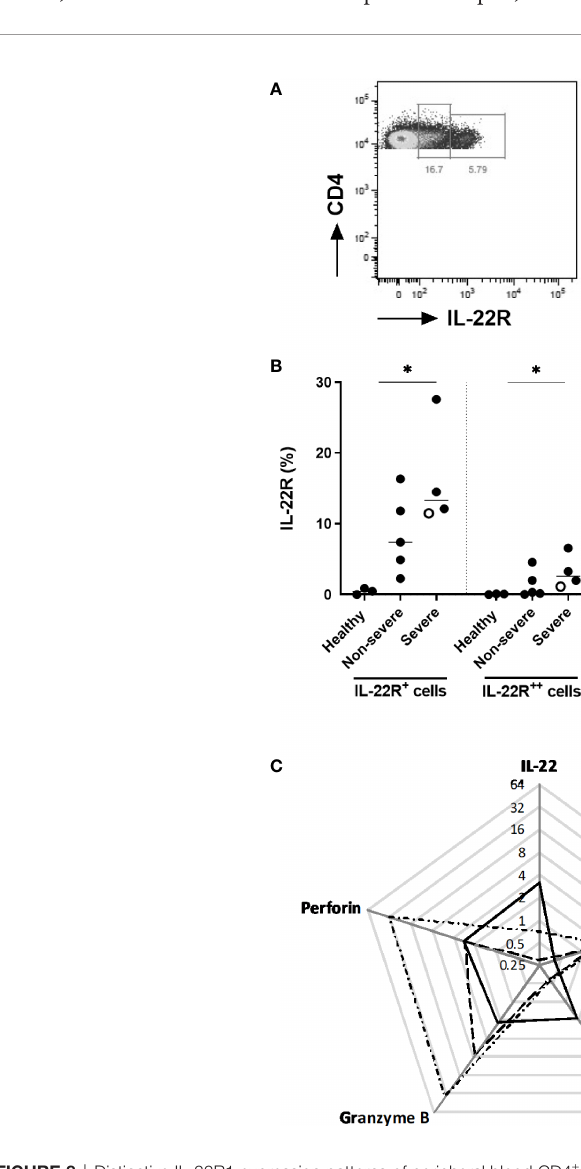
FIGURE 8 | Distinctive IL-22R1 expression patterns of peripheral blood CD4 + lymphocytes. (A) Representative pseudo-color plot and histogram showing IL-22R + and IL-22R ++ expression on CD4 + T lymphocytes from a representative severe COVID-19 patient. (B) Percentages and median fl uorescence intensity of IL-22R1 + and IL-22R1 ++ CD4 + T cells on the day of inclusion for healthy controls (n=3), non-severe (n=5) and severe patients (n=4). The patient who died from COVID-19 is represented as an empty circle. The horizontal bars indicate the medians of the results within each column. (C) Radar chart of the median frequencies of IL-22,